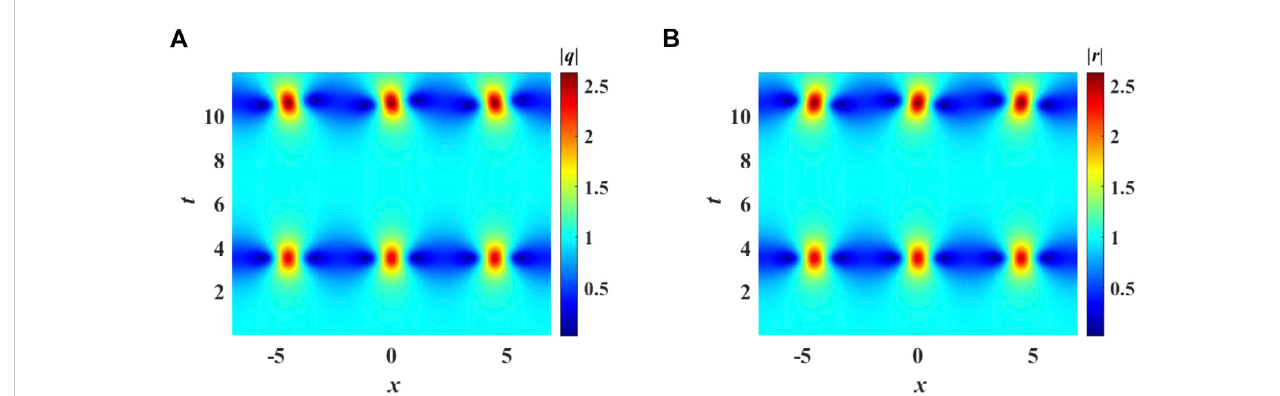
FIGURE 4 FPUT with parameters α = 1, β = 1 × 10 − 6 , κ = − 1, ρ = 1, γ 1 = 0, μ = 0.01, η = 1.4. (A) Modulus of waveguide, | q |; (B) | r |.